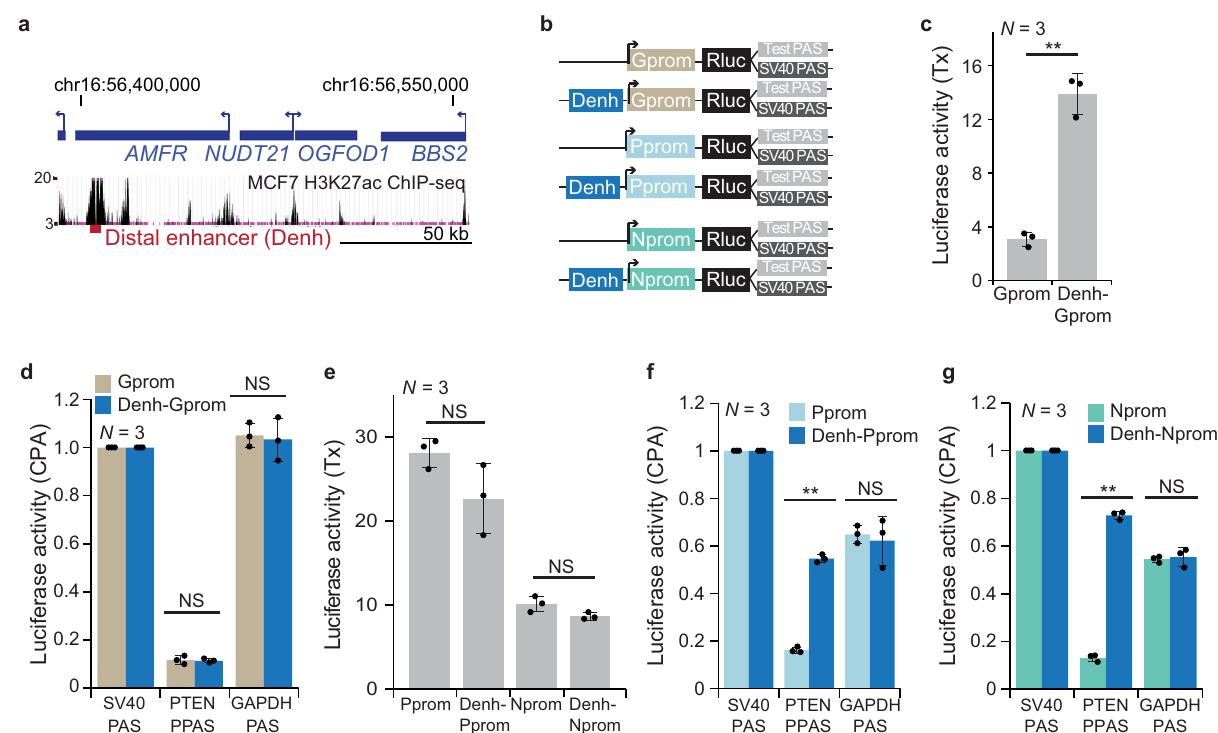
Fig. 3 A distal enhancer regulates CPA activity of proximal PAS. a UCSC genome browser snapshot showing the genomic context of the NUDT21 gene locus. The region with the local maximum of acetylated H3K27 measured by ChIP-seq in MCF7 cells was de fi ned as distal enhancer (Denh). b Schematic of reporter constructs used to investigate enhancer-dependent CPA activity in the context of three promoters. The GAPDH promoter (Gprom) drives a single- UTR gene, whereas the Pprom and NUDT21 (Nprom) promoters drive multi-UTR genes. Shown as in Fig. 2a. c Enhancer-dependent transcriptional activity of the Gprom shown as in Fig. 2b. Data are shown as mean ± std of n = 3 biologically independent experiments. Two-tailed t -test for independent samples was performed. ** P = 0.0005. d Enhancer-dependent CPA activity in the context of the Gprom shown as in Fig. 2c. Data are shown as mean ± std of n = 3 biologically independent experiments. Two-tailed t -test for independent samples was performed. NS, not signi fi cant. e As in ( c ), but enhancer-dependent transcriptional activity of two multi-UTR gene promoters is shown. Data are shown as mean ± std of n = 3 biologically independent experiments. Two- tailed t -test for independent samples was performed. NS not signi fi cant. f As in ( d ), but enhancer-dependent CPA activity in the context of the Pprom is shown. Data are shown as mean ± std of n = 3 biologically independent experiments. Two-tailed t -test for independent samples was performed. ** P = 1 × 10 − 8 . g As in ( d ), but enhancer-dependent CPA activity in the context of the Nprom is shown. Data are shown as mean ± std of n = 3 biologically independent experiments. Two-tailed t -test for independent samples was performed. ** P = 1 × 10 − 5 . Source data for fi gures ( c – g ) are provided as a Source Data fi